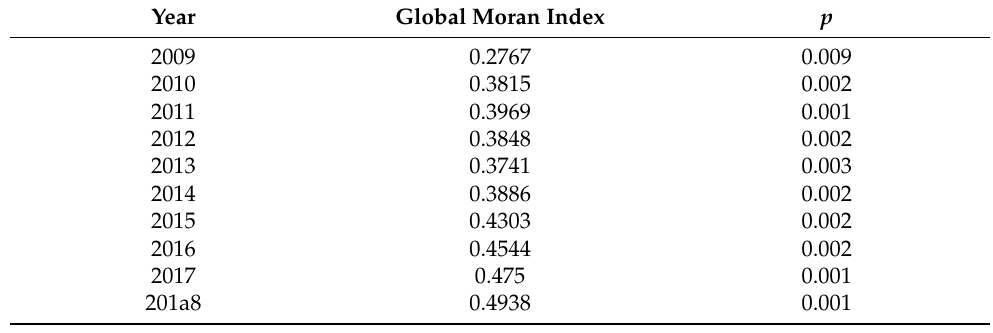
Table 4. Global Moran index from 2009 to 2018.